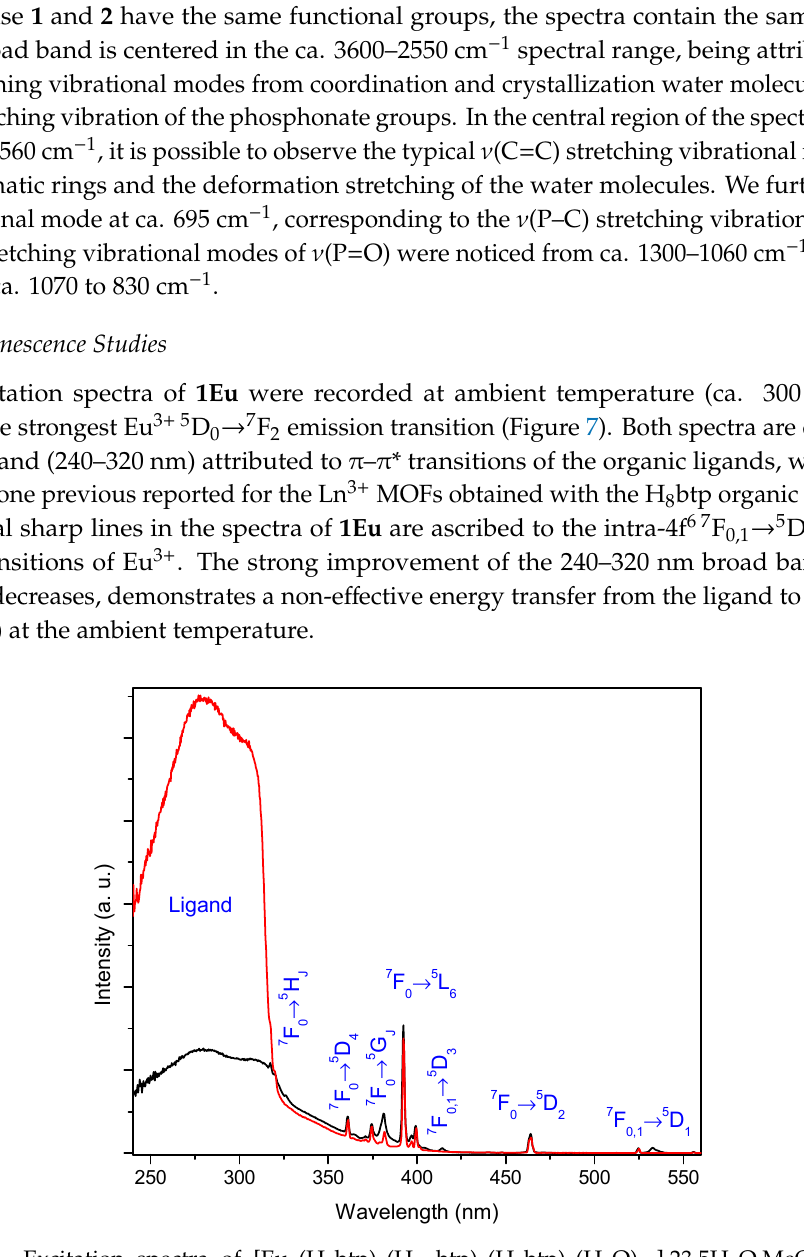
Figure 7. Excitation spectra of [Eu 7 (H 5 btp) 4 (H 5.5 btp) 2 (H 6 btp) 2 (H 2 O) 12 ] · 23.5H 2 O · MeOH ( 1Eu ), recorded at ambient temperature (black line) and at 12 K (red line), while monitoring the Eu 3+ emission at 610.5 nm.